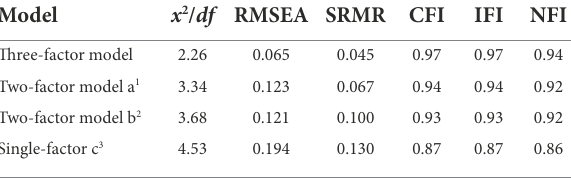
TABLE 2 Confirmatory factor analysis results.